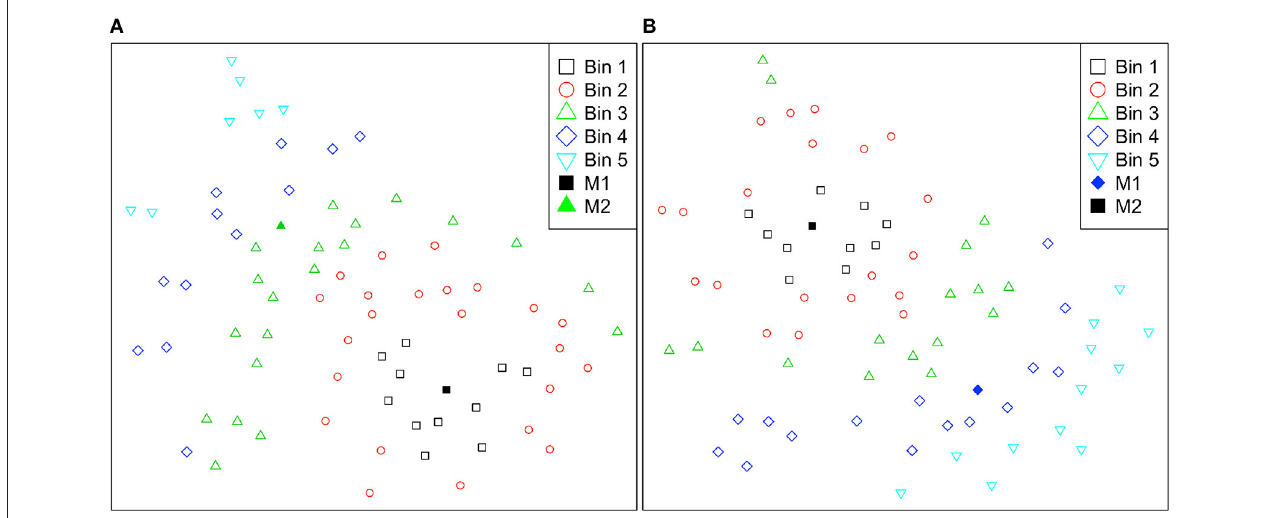
FIGURE 5 | Student practice behavior representations are divided into five bins according to their Euclidean distances to cluster medoids and color-coded for easier interpretation on the 2-D t-SNE projection. Bins are numbered from 1 to 5 in increasing average distance for (A) Cluster 1 medoid (M1) and (B) Cluster 2 medoid (M2).